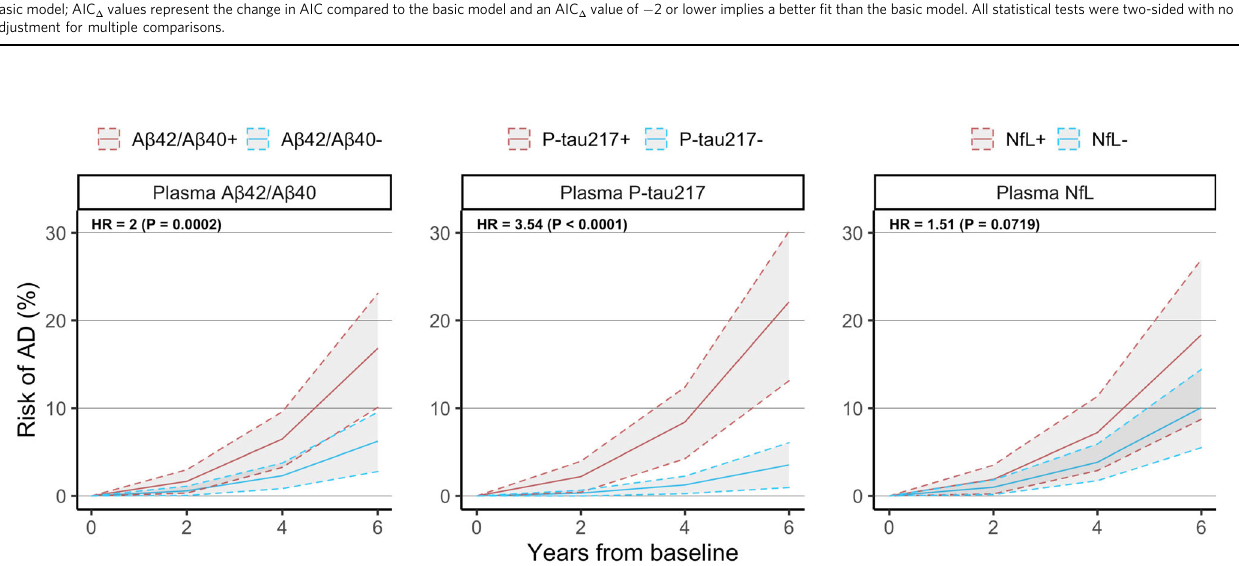
Fig. 2 Relationship between plasma biomarkers and conversion to AD. This fi gure shows the risk of AD dementia overtime expected for a biomarker- negative or biomarker-positive CU individual with average age, average education, and female sex. Hazard ratios at the top left of each panel are presented in terms of “ increased risk of converting to AD dementia per standard deviation change in biomarker value ” and are derived from Cox regression models with conversion to AD dementia as outcome and age, sex, education, plus each plasma biomarker included separately from each other. All statistical tests were two-sided with no adjustment for multiple comparisons. Shaded areas represent 95% con fi dence intervals of the regression lines.